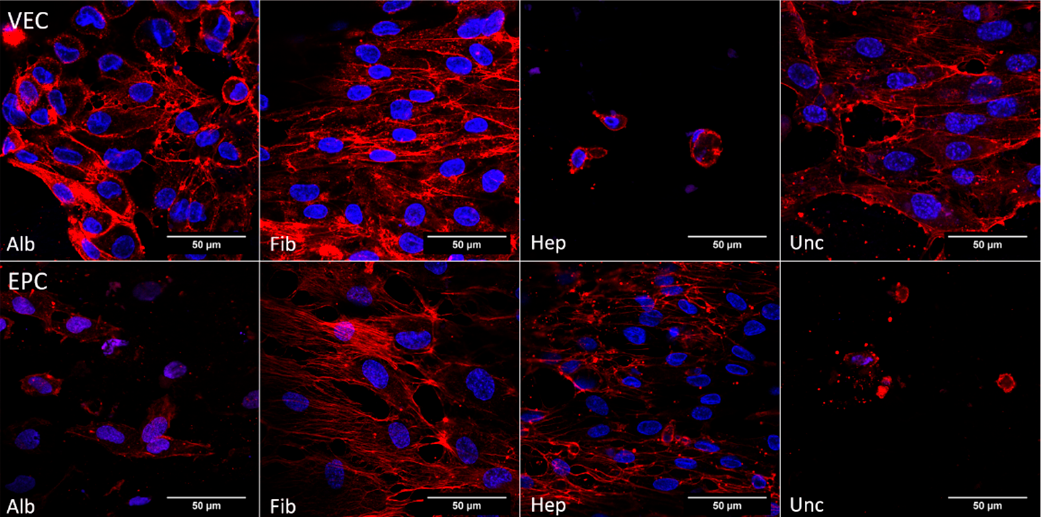
Figure 7. Confocal microscopy images of BNC grafts seeded with vascular endothelial cells (VEC) and endothelial progenitor cells (EPC) under dynamic conditions. Cell nuclei were stained against DAPI (blue) and the F-actin of the cytoskeleton was stained with rhodamine phalloidin (red). The fibronectin group showed a pronounced expansion of the cytoskeleton for both cell types. The VECs also showed a distinct expression of F-actin filaments on uncoated grafts. For the albumin group, the F-actin filaments were concentrated around the nuclei, indicating less spread of the cell bodies, and the heparin group showed no distinct signal of F-actin filaments. For EPCs, cells in the albumin and uncoated groups did not show clearly recognizable structures of F-actin filaments. EPCs on heparin-coated grafts showed a distinct F-actin signal.